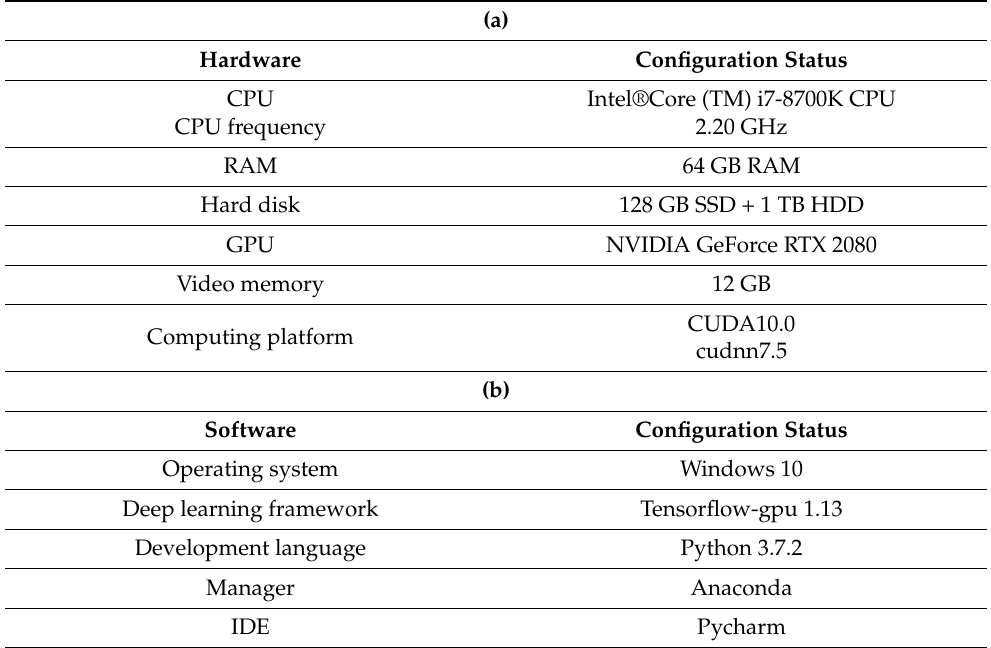
Table 2. (a) The configuration of hardware. (b) The configuration of